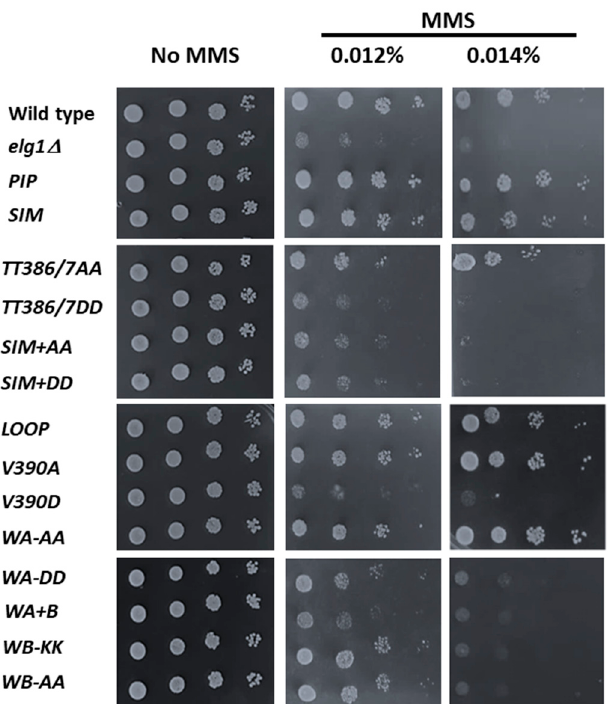
Figure 2. DNA damage sensitivity assay for different ELG1 mutations. Serial fivefold dilutions of yeast cultures on SD-complete without and with methyl methanesulphonate (MMS) at the indicated concentrations show different sensitivities of elg1 mutants. elg1 ∆ strains were transformed with a centromeric pRS415 plasmid collection containing different ELG1 mutations. The strain described as “Wild type” carried the ELG1 gene, and the one described as “ elg1 Δ ” carried an empty vector.